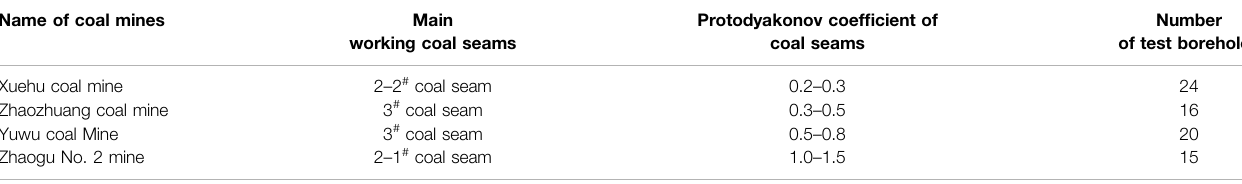
TABLE 1 | Basic conditions of the test mines.